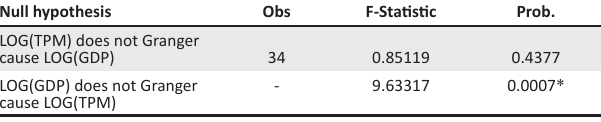
TABLE 6: Vector autoregression Granger causality.